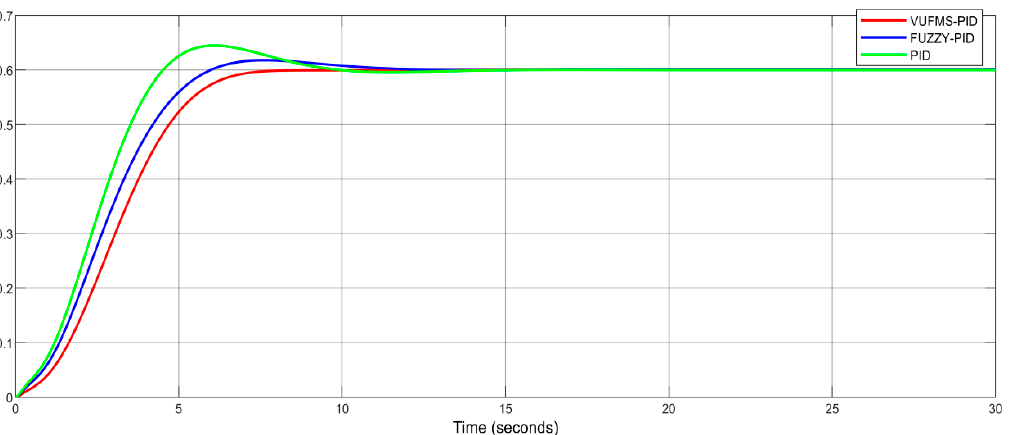
Figure 9. Payload’s swing angle ( θ ) using VUFMS-PID, FUZZY-PID and PID controller under working condition 1. Figure 10. Trolley’s position using VUFMS-PID, FUZZY-PID and PID controller under working condition 2.